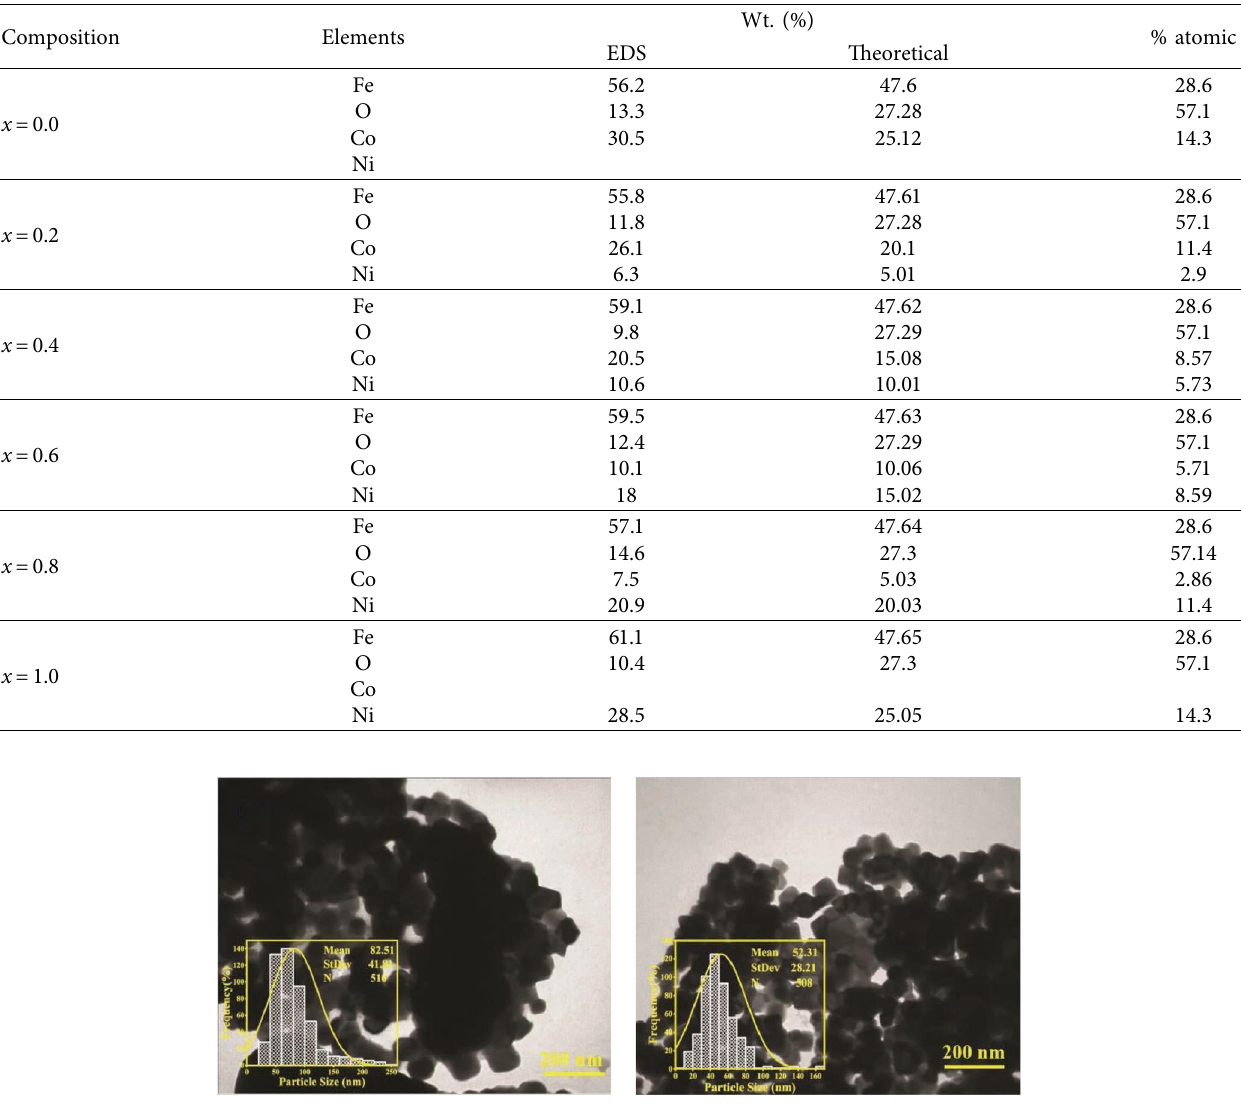
Table 5: Experimental values obtained from the spectrum of energy dispersive X-ray analysis for Co calcinated at 800 ° C. Composition Elements